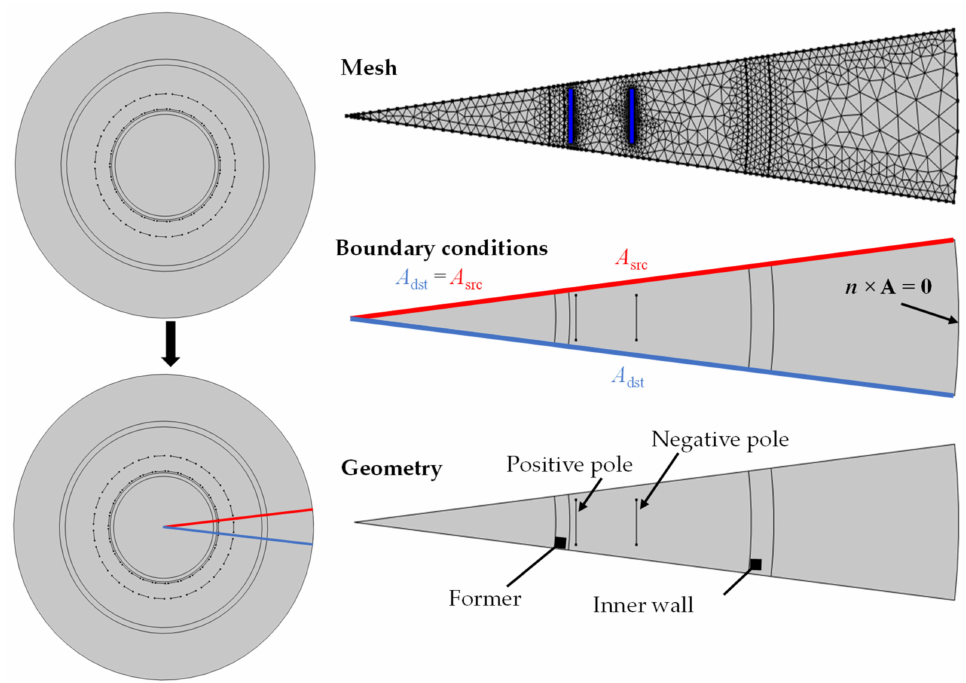
Figure 7. A 2D model of the bipolar coaxial cable with a 360 ◦ / N angle sectorial cut, with N being the number of tapes equal to 27. Specific views are given of the mesh, the boundary conditions, and the description of the different elements